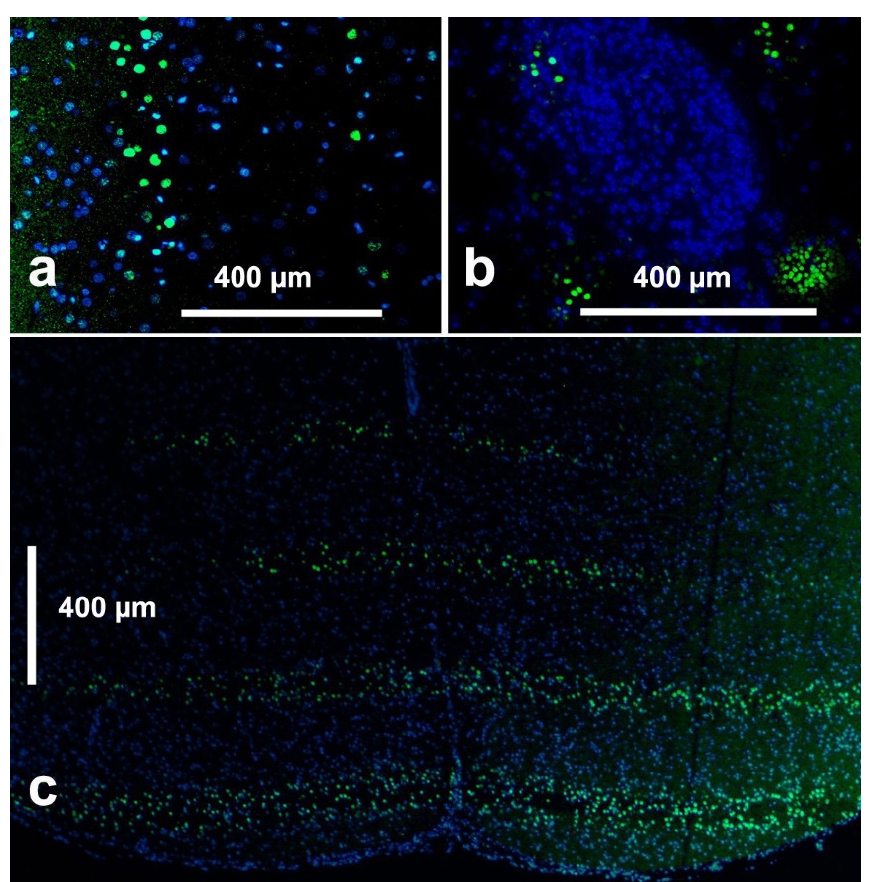
Figure 3. Immunostaining (gammaH2AX) highlighting irradiation-induced DNA double strand breaks. Lateral view after the monoplanar MBI ( a ), PBI ( b ) and the axial view (along the direction of the beams into the tissue): seen from above, it looks the same after the monoplanar MBI and PBI ( c ). Images shown are obtained from animals receiving the SIB first, to demonstrate the DNA double strand breaks corresponding to the beam geometry.